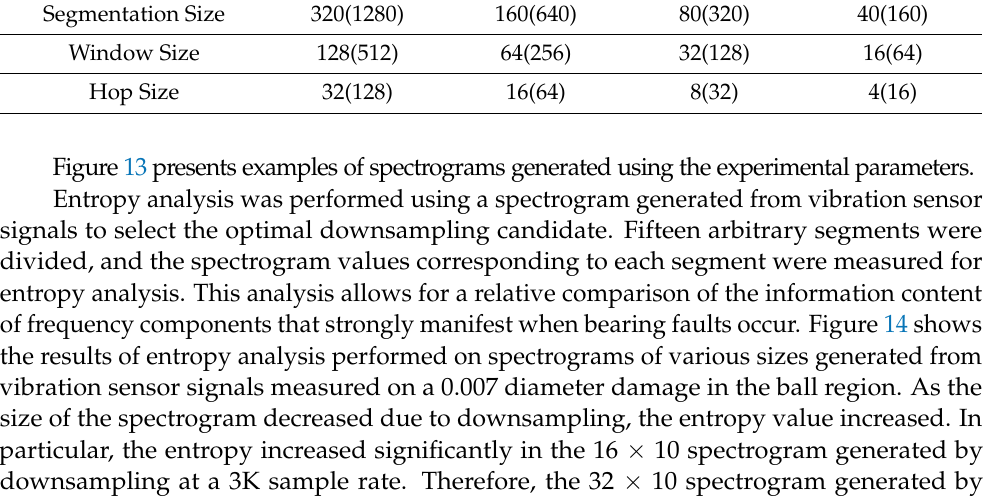
Figure 13. Examples of input spectrogram data of 65 × 10, 32 × 10, 16 × 10, and 8 × 10 sizes.